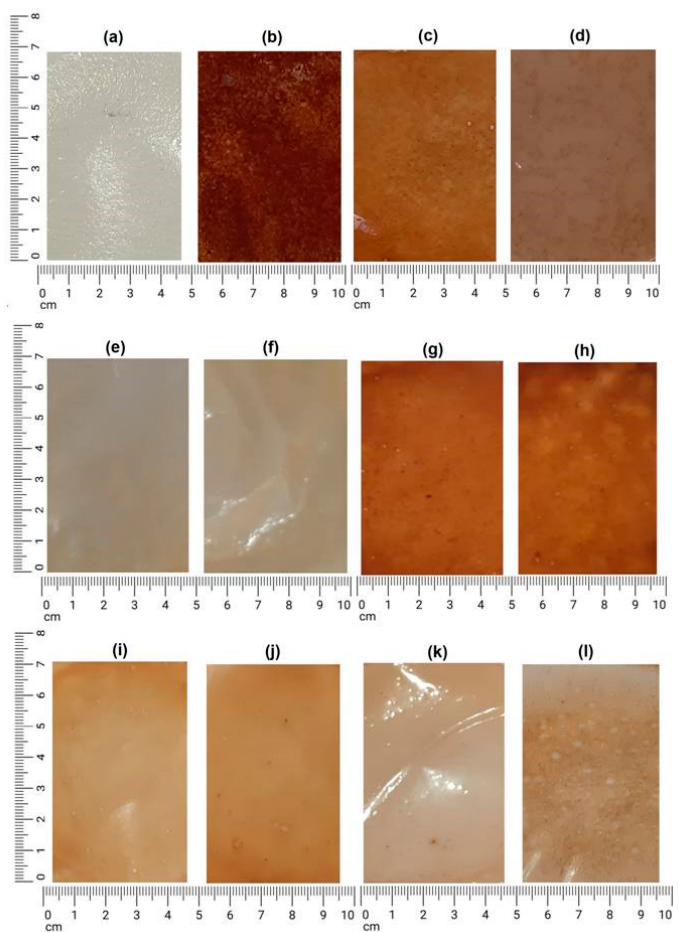
Figure 3. Membranes of synthesized chitosan. ( a ) M0. ( b ) M1. ( c ) M2. ( d ) M3. ( e ) M4. ( f ) M5. ( g ) M6. ( h ) M7. ( i ) M8. ( j ) M9. ( k ) M10. ( l ) M11.